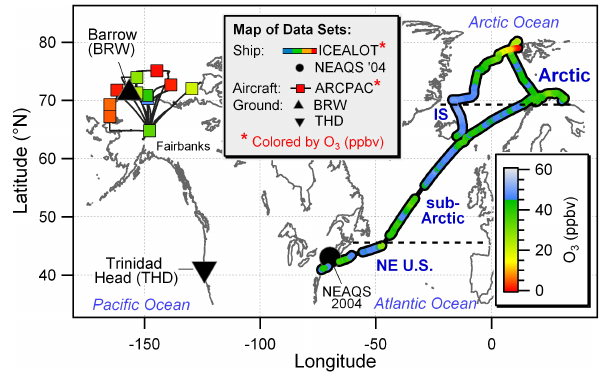
Fig. 1. Locations of the data sets used in this analysis. The four data subsets of the ICEALOT campaign aboard the R/V Knorr , which include the northeastern United States (NE US), sub-Arctic, Arctic, and Iceland (IS), are identified. The ICEALOT ship track and the flask samples collected along the ARCPAC flight tracks in Northern Alaska are colored by measured O 3 mixing ratios. Additional data sets include flask samples collected at ground-based observatories in Barrow, Alaska, (BRW) and Trinidad Head, California, (THD) as well as ship-based studies from the 2004 New England Air Quality Study (NEAQS ’04) aboard the R/V Brown